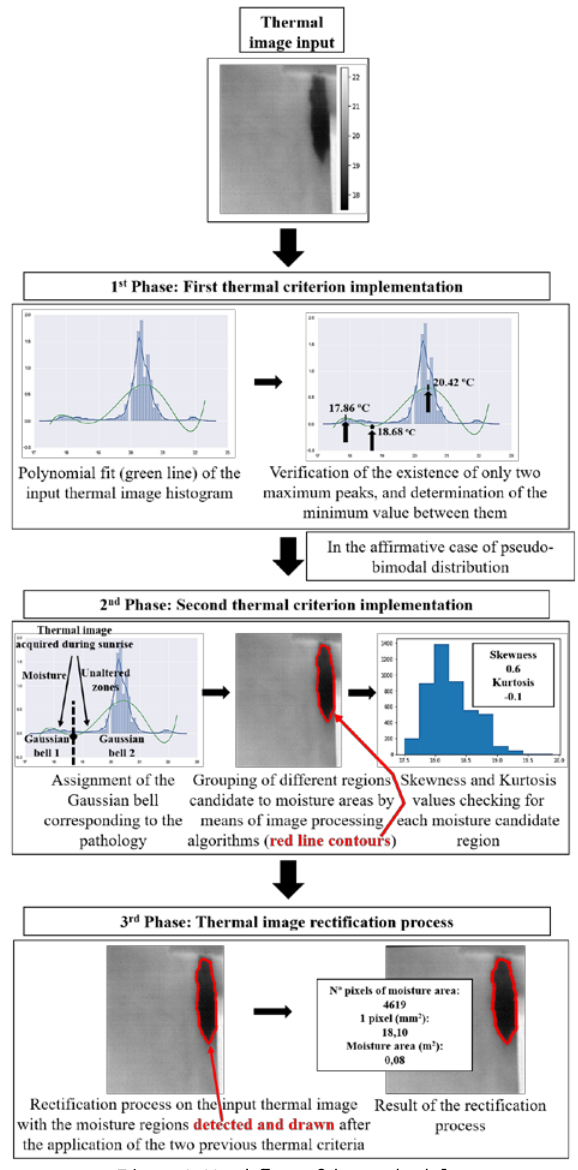
Figure 1. Workflow of the